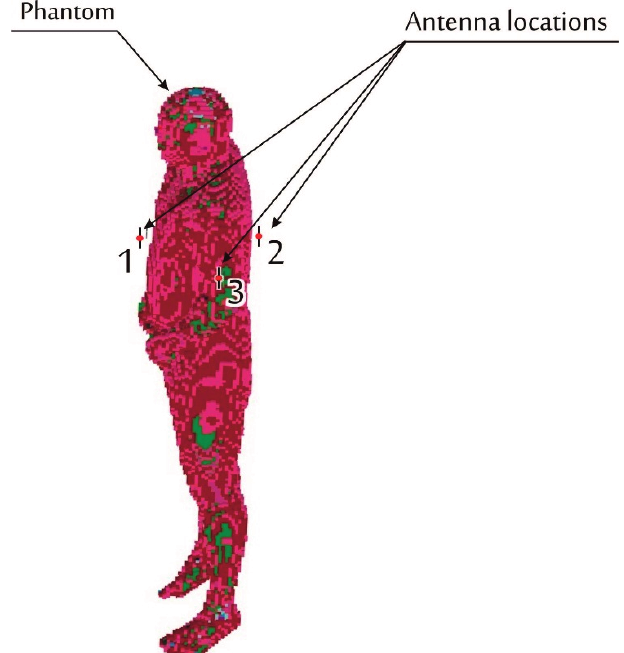
Figure 1. Graphical representation of the NMR Hershey body phantom in Remcom XFdtd ® (10 mm voxels) and antenna location: 1–chest, 2–back,